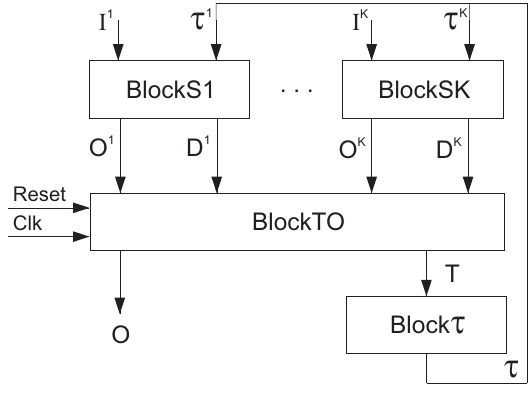
Figure 3. Structural diagram of P T Mealy